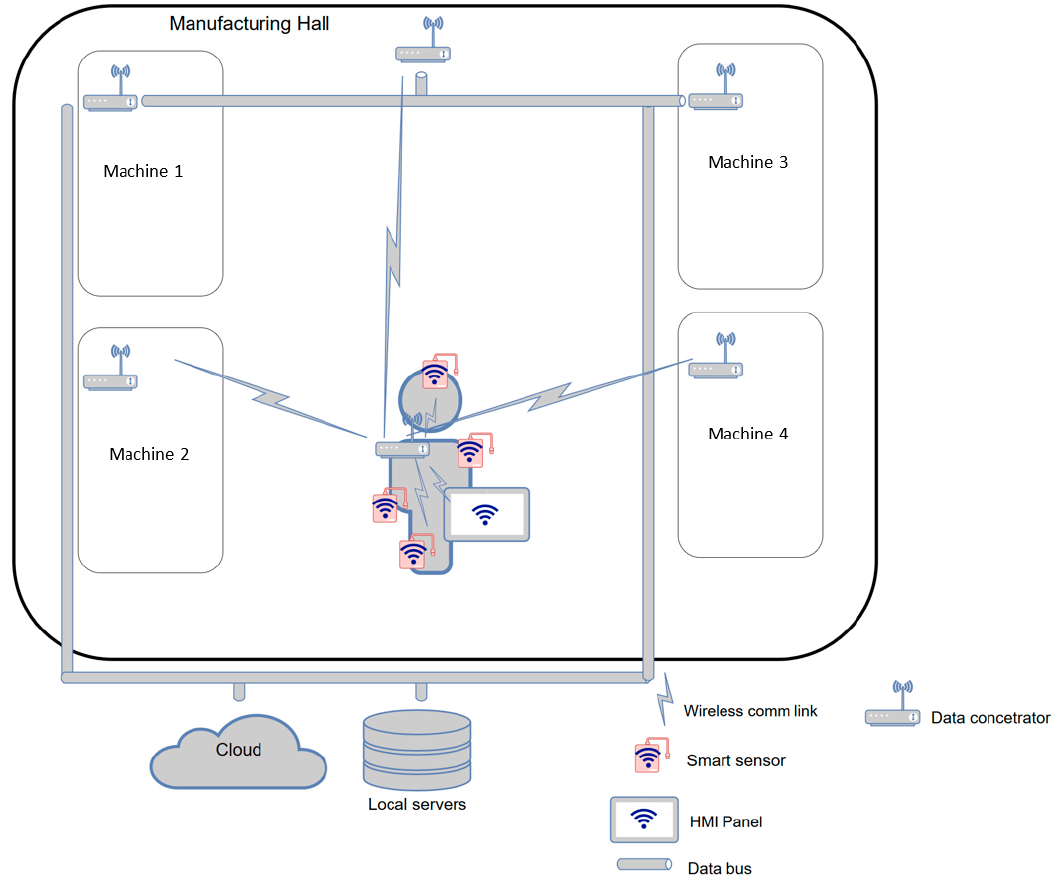
Figure 7. Use case II , with the data concentrator directly in the SmartJacket.